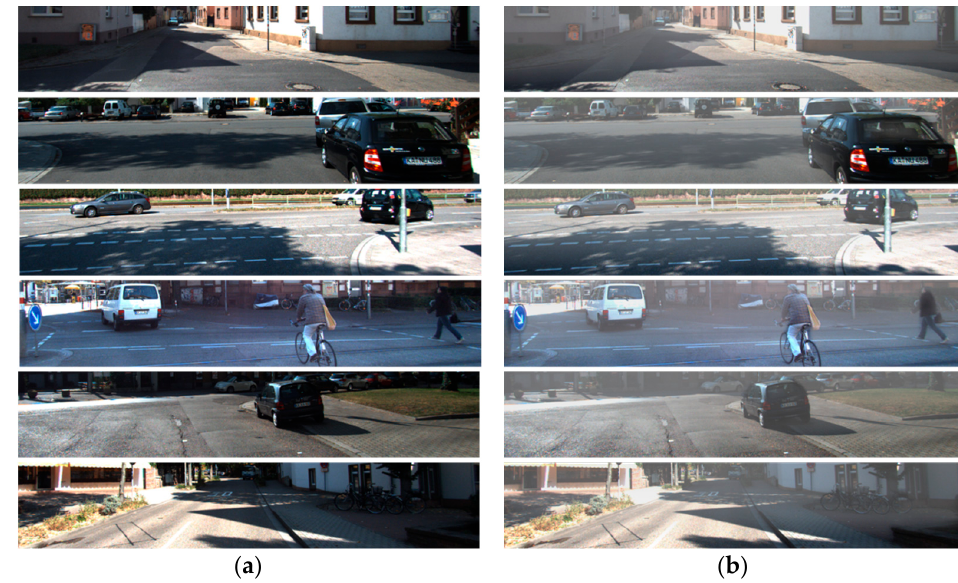
Figure 7. Synthetic haze image with ground truth: ( a ) ground truth; ( b ) synthetic haze image.